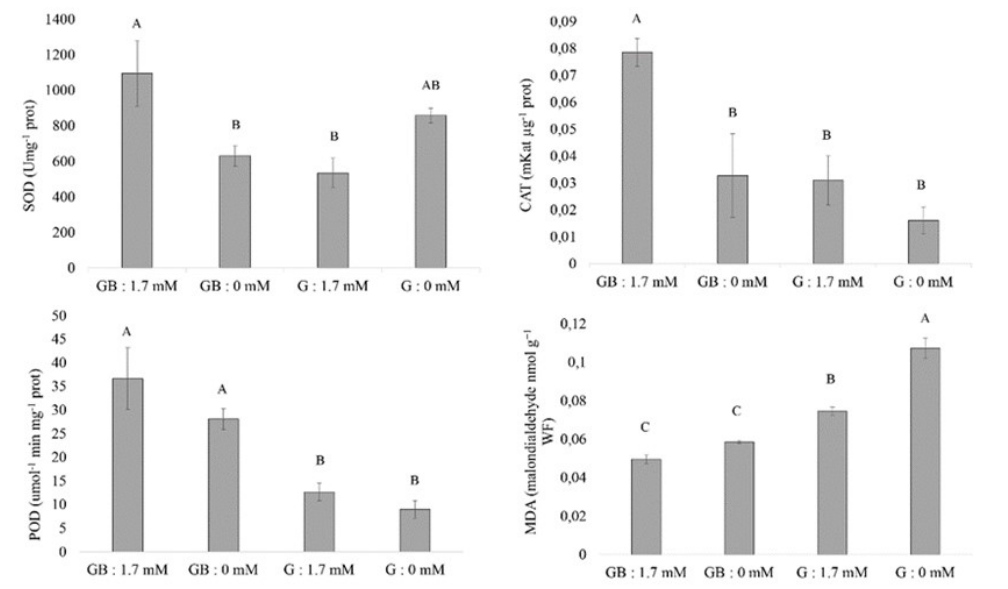
Figure 3. Antioxidant enzymes, superoxide dismutase (SOD, mg U protein − 1 ), peroxidase (POD, µ mol of purpurogallin min − 1 mg protein − 1 ), catalase (CAT, µ Kat µ g protein − 1 ), and lipid peroxida- tion (MDA, malondialdehyde nmol g FW − 1 ) of Glycine–Bradyrhizobium and Glycine cultivated with 0 mM and 1.7 mM nitrate at 41 days after sowing. G, Glycine ; GB, Glycine–Bradyrhizobium